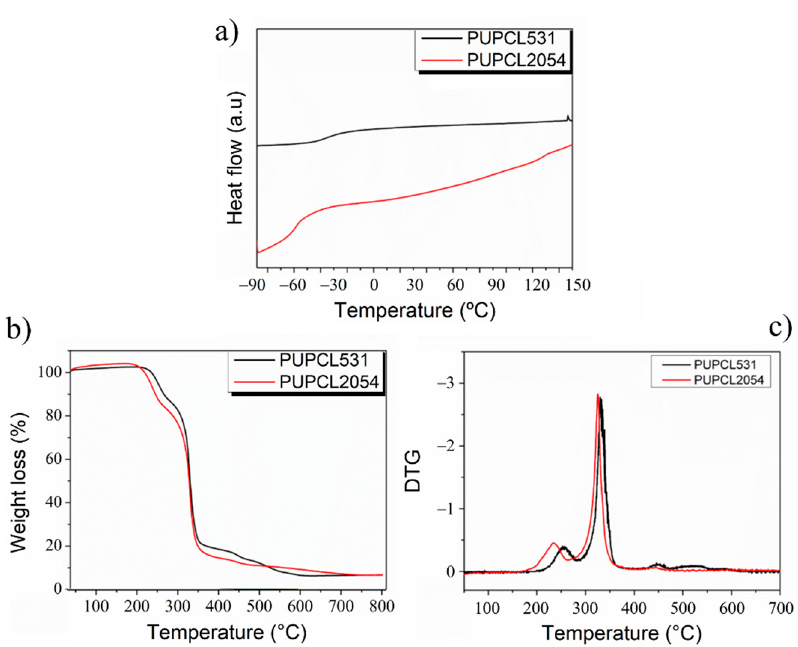
Figure 3. ( a ) DSC second heating scan of PUPCL531 (black) and PUPCL2054 (red). ( b ) TGA thermo- gram and ( c ) derivative of the weight loss in function of the temperature for both materials.